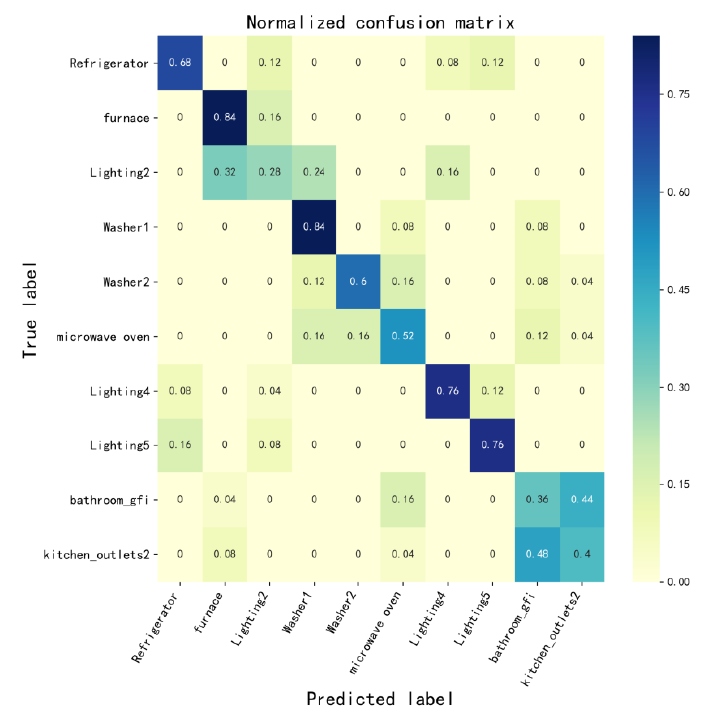
Figure 8. Features performance on REDD based on the average value method.